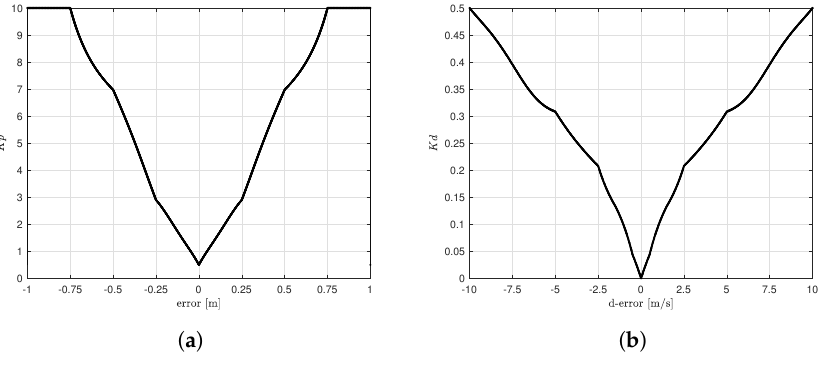
Figure 6. Ouput fuzzy surfece for ( a ) K p and ( b ) K d